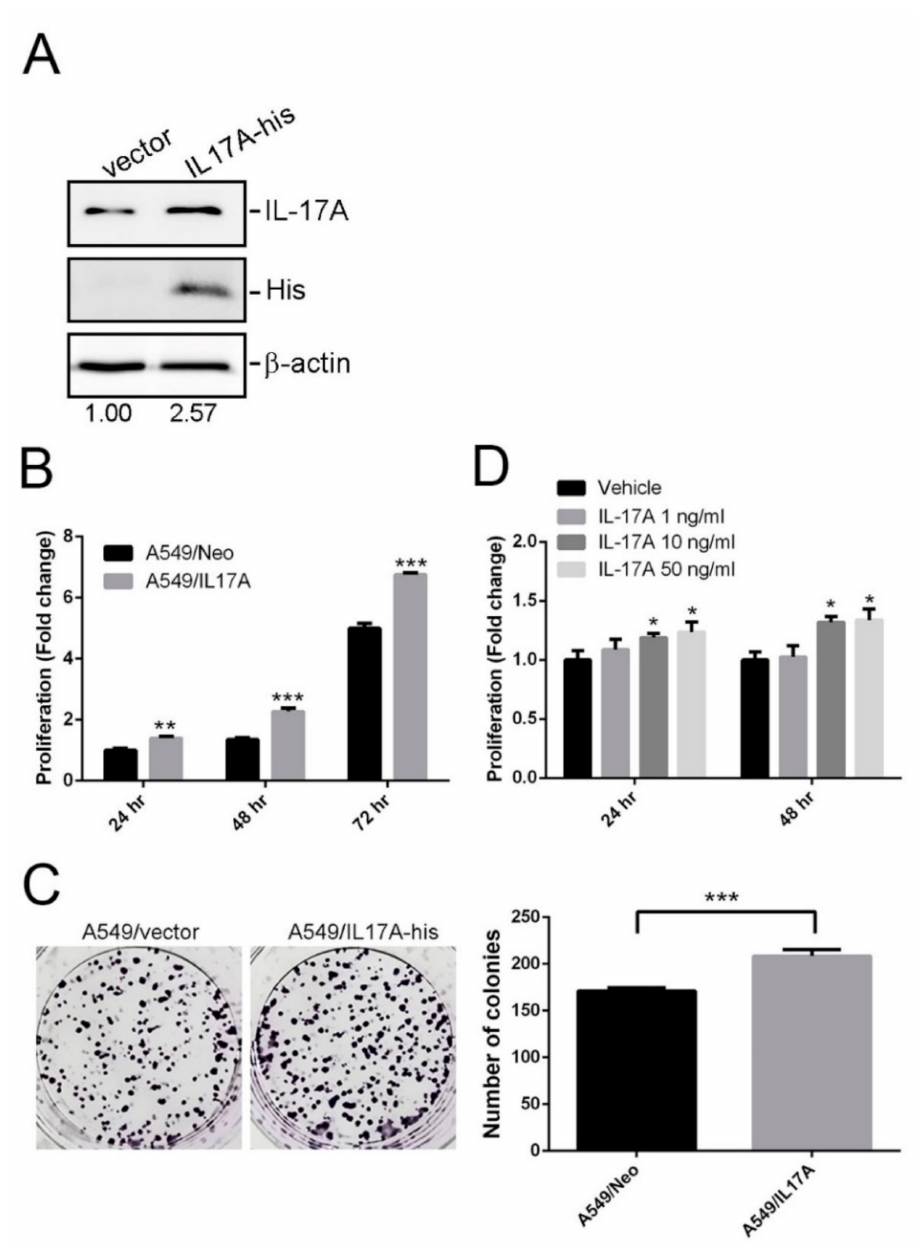
Figure 1. IL-17A promotes proliferative and colony forming abilities of A549 lung adenocarcinoma (LUAD) cells harboring wild-type (WT) EGFR and a mutant (MT) KRAS. ( A ) Western blot analysis of IL-17A expressions in A549 cells after transfecting an IL-17A-expressing vector (IL-17A-His). ( B , D ) Proliferation rates of IL-17A-overexpressed ( B ) or IL-17A recombinant-treated ( D ) A549 cells were measured by performing CCK8 assays. viability. ** p < 0.01, *** p < 0.001, compared to the control (A549/Neo) group. * p < 0.05, compared to vehicle treatment group. ( C ) Effects of IL-17A on the long-term growth (7 days) of A549 cells were evaluated using a colony formation assay. Left panel: Representative photomicrographs. Right panel: Data are presented as the mean ± SD of three independent experiments. *** p < 0.001, compared to the control